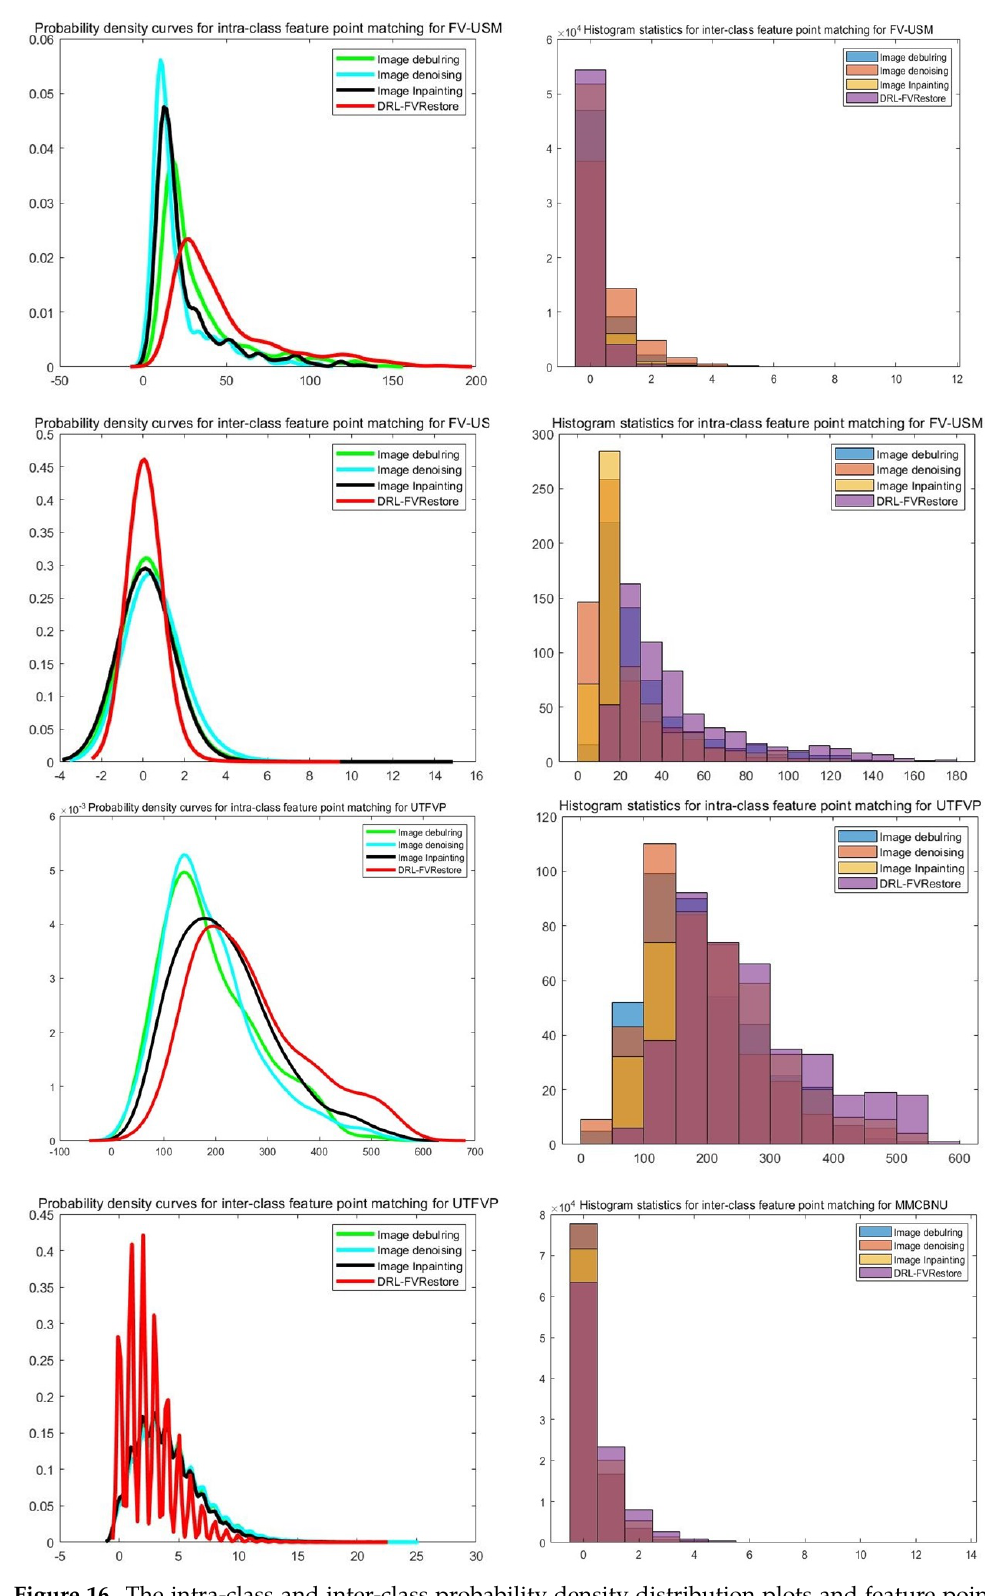
Figure 16. The intra-class and inter-class probability density distribution plots and feature point histogram statistical plots of DRL-FVRestore on the UTFVP and FV-USM